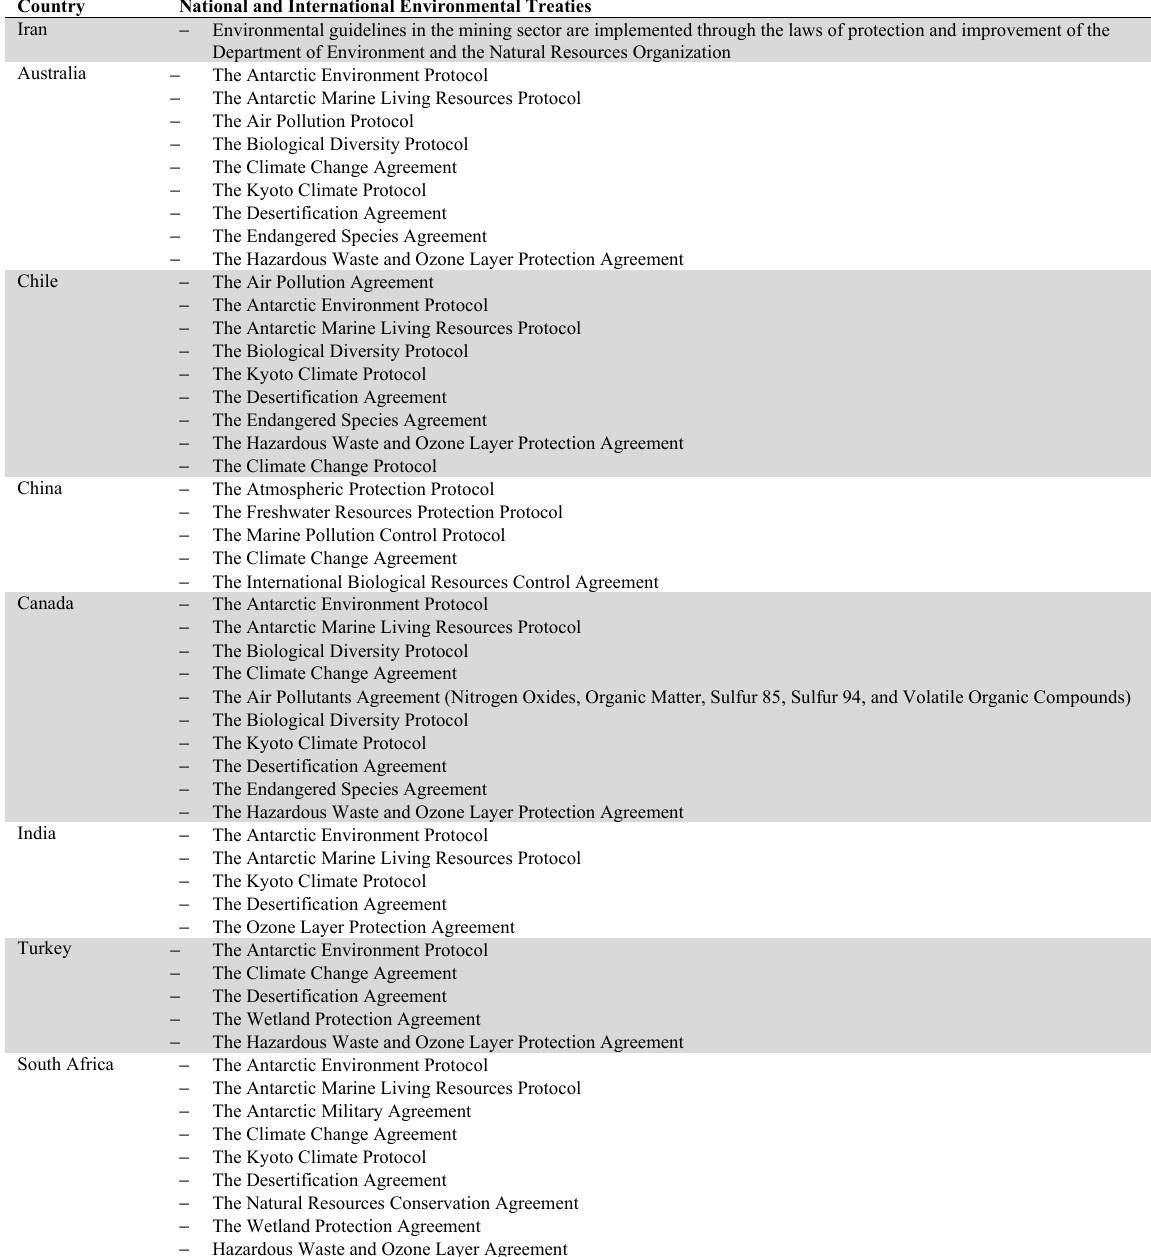
Country National and International Environmental Treaties